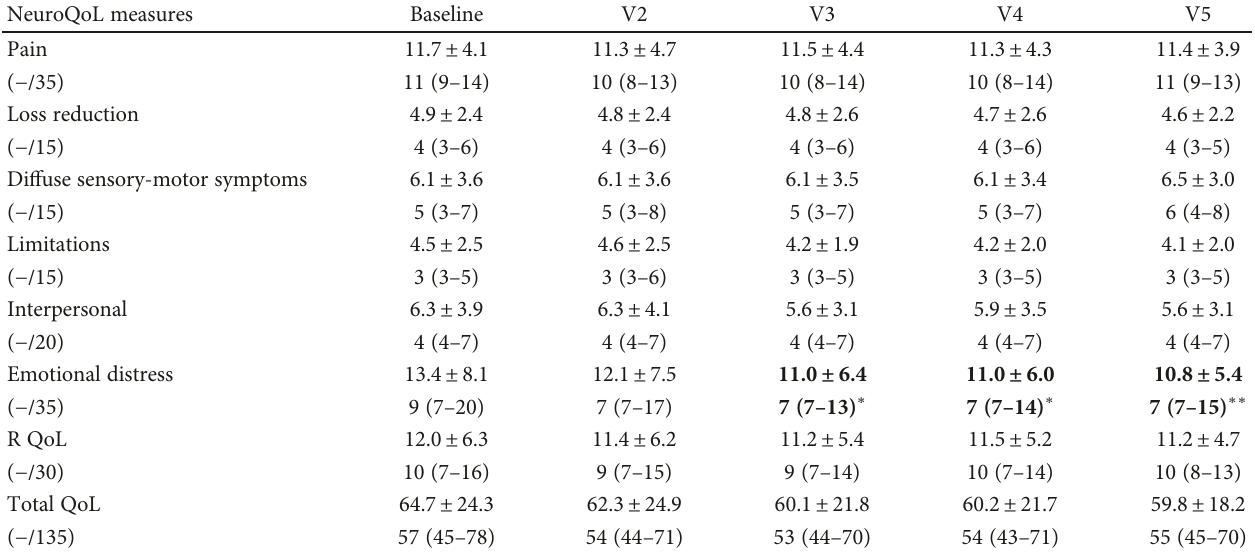
Table 3: NeuroQoL measures from baseline to fi nal visit.